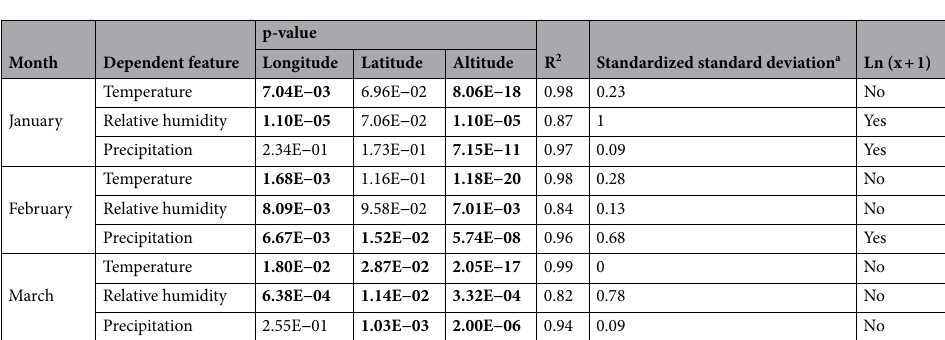
Table 3. Results of the first-stage statistical analysis and models per month. The bold p values denote significant parameters (< 0.05). a Standardized standard deviation of the cross-validation scores of the estimation